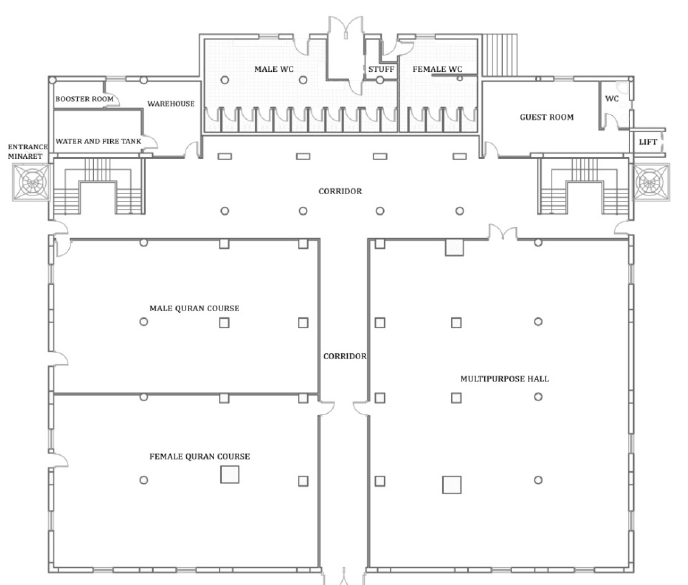
Figure 10. Layout plan of Güzeloba Mosque.